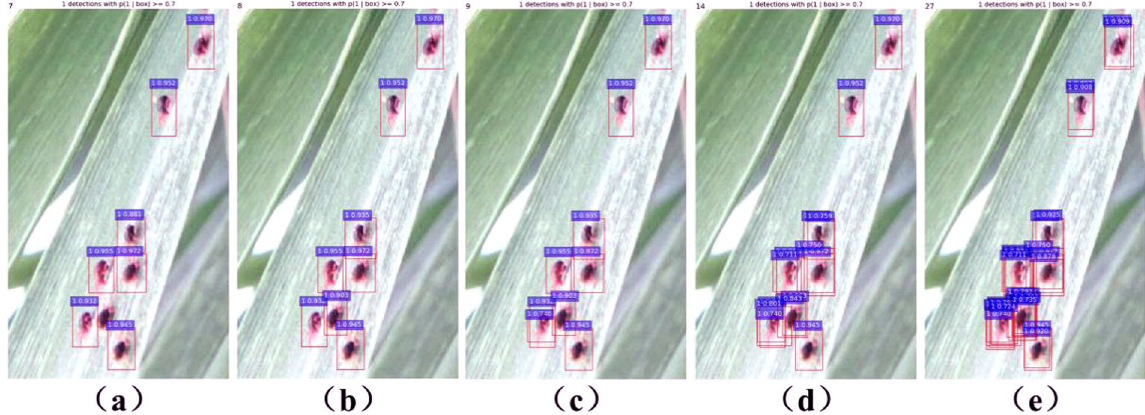
Figure 12. An example of the visual comparison of localization and counting results under different NMS thresholds, nth . ( a ) nth = 0. ( b ) nth = 0.1, 0.2, 0.3, 0.4, 0.5. ( c ) nth = 0.6. ( d ) nth = 0.7. ( e ) nth = 0.8. All the images for this example are from the dataset A taken with 600 × 1000